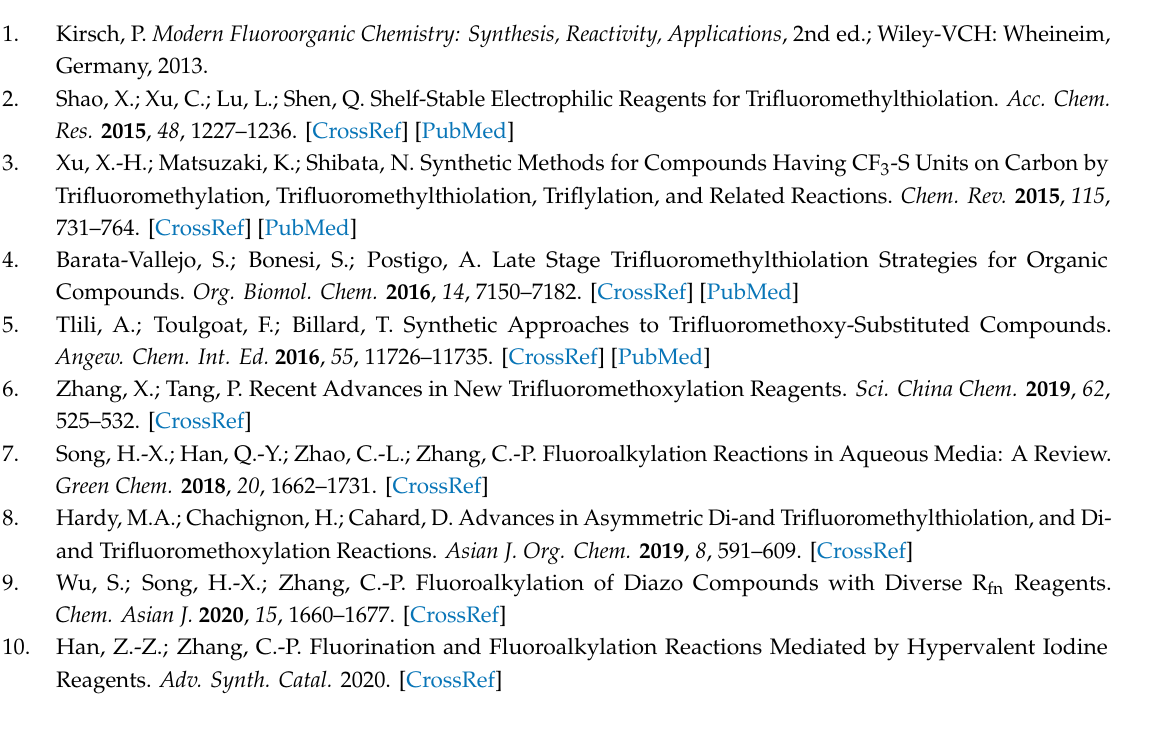
Supplementary Materials: The brief description of screening the optimal reaction conditions, general procedures for hydrotrifluoromethylchalcogenation of unactivated terminal alkenes with [Me 4 N][XCF 3 ] (X = S, Se), and TfOH, control experiments for mechanistic insights, characterization data, and NMR spectra of the products (PDF) are available